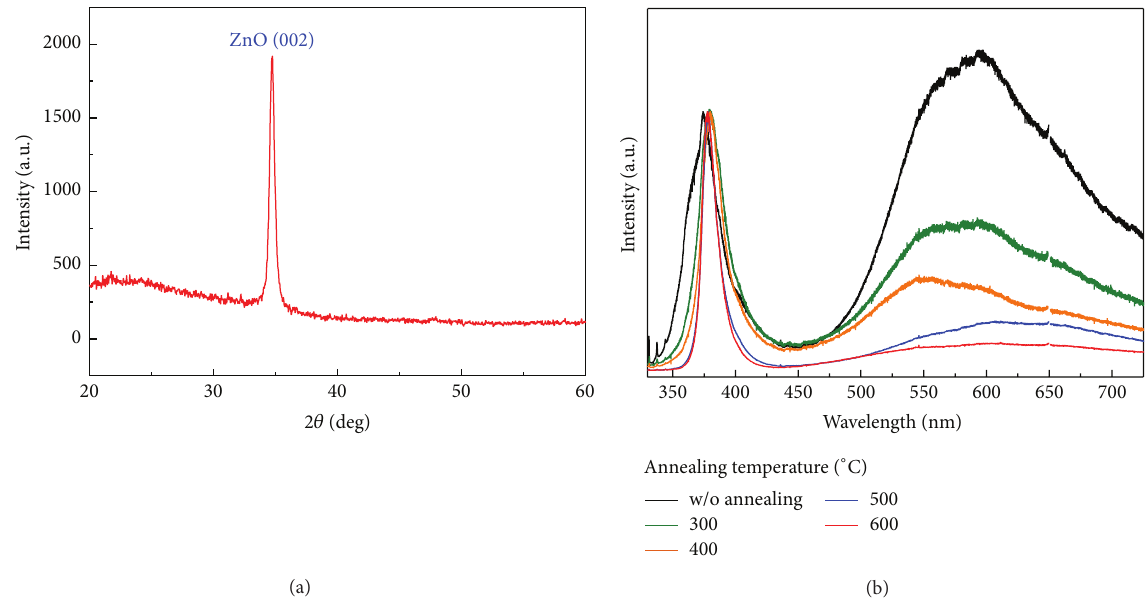
Figure 2: (a) XRD pattern of prepared n-ZnO film with quasi-monocrystal structure fabricated via HTG. (b) PL spectra of ZnO film (HTG) for various annealing temperatures in